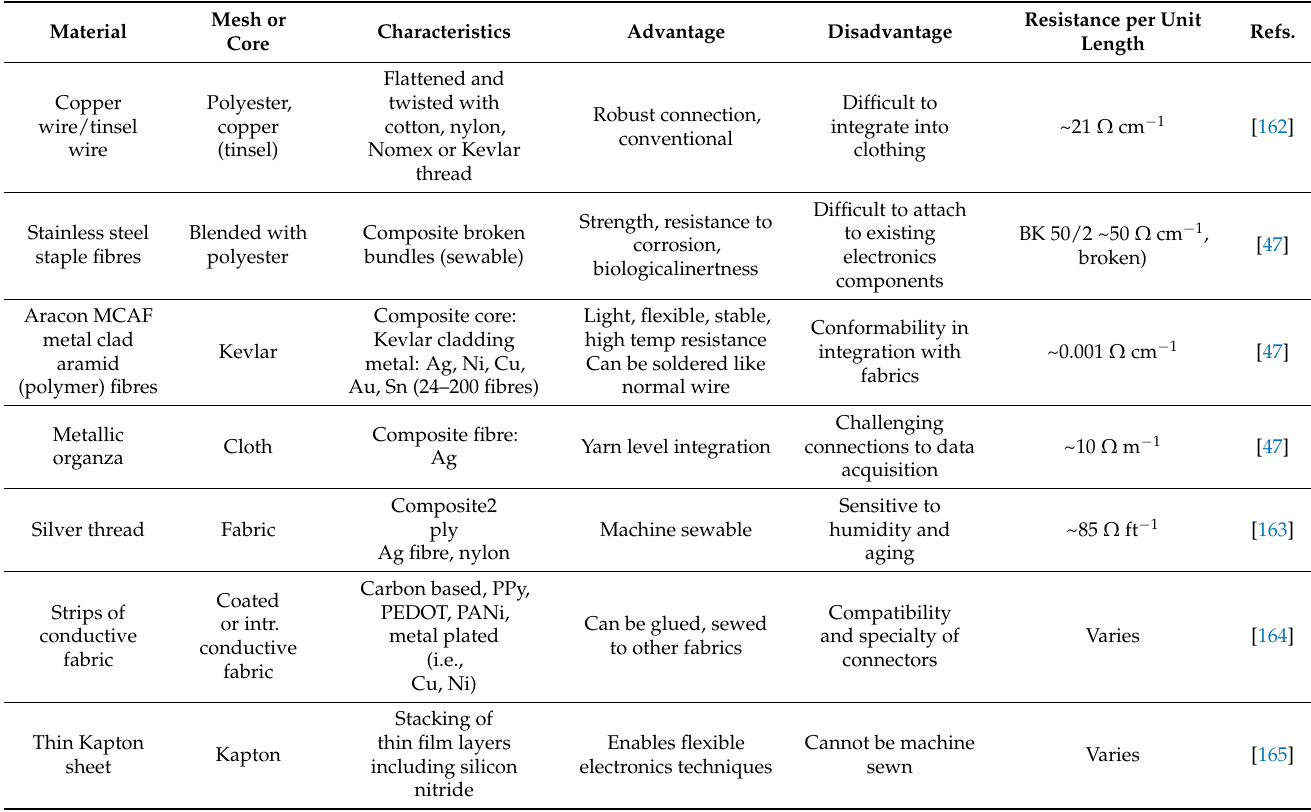
Table 6. Application of fibres and yarns along with conductive features in smart